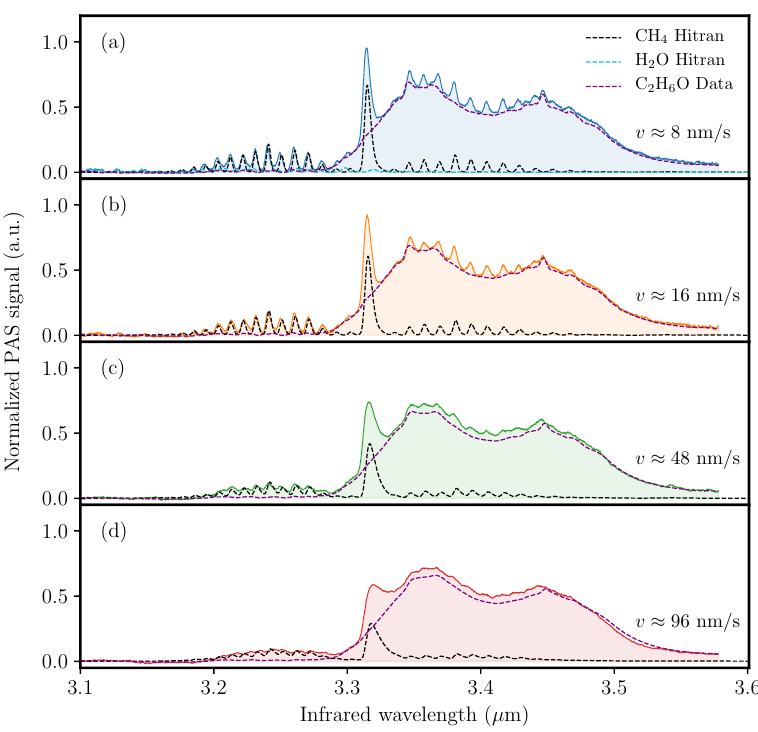
Figure 7. Acquired QEPAS spectra of approximately (87 5) ppm of methane in a gaseous mixture with ± evaporated ethanol and water. The spectra were obtained using wavelength scan rates of ( a ) 8 nm s − 1 , ( b ) 16 nm s − 1 , ( c ) 48 nm s − 1 , and ( d ) 96 nm s − 1 . The black dashed curves represent methane and the cyan dashed curve represent the water absorption data from the Hitran database with an appropriate instrumental profile (see text). The purple dashed curves represent measured photoacoustic spectra for